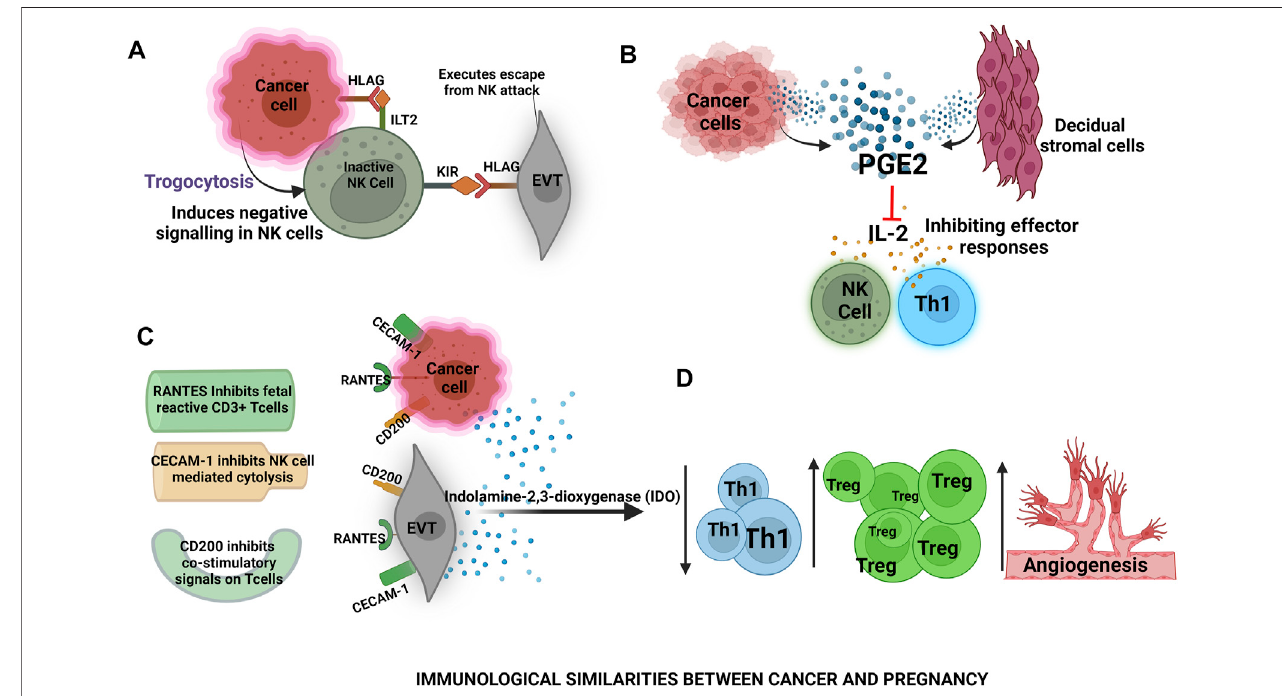
FIGURE4| Immunologicalsimilarities betweencancerand pregnancy- (A) In cancer,HLA-GcausessuppressionofNKcells activity andinplacentaldevelopment trophoblasts expressing the human leukocyte antigen G-5 (HLAG) induce killer inhibitory receptors on NK cells (B) Cancer cells and decidual stromal cells release prostaglandins thatinhibit IL-2production thus,masking pro-in fl ammatoryresponses by NKcells and Thelper 1cells (C) RANTES, CECAM-1, CD200are thecommon surface molecules among cancer cells and extravillous trophoblasts (EVTs) that inhibit pro-in fl ammatory cellular responses (D) Cancer cells and EVTs secrete indolamine-2,3-dioxygenase (IDO) which is toxic to Th1 cells thereby ameliorating the Th1 expression and increasing regulatory T (Treg) cell responses to promote angiogenesis for the fetus and cancer survival.